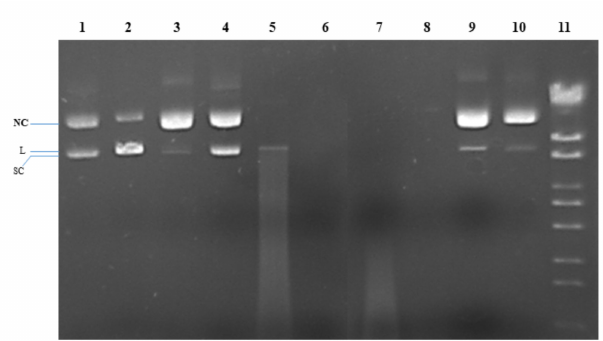
Figure 6. Gel electrophoresis image of pRSII425 (100 ng / µ L) after incubation for 1 h at 37 ◦ C with the compounds, except for Eco RI (5 min). Line 1: pRSII325; Line 2: pRSII325 / Eco RI (partial digestion); Line